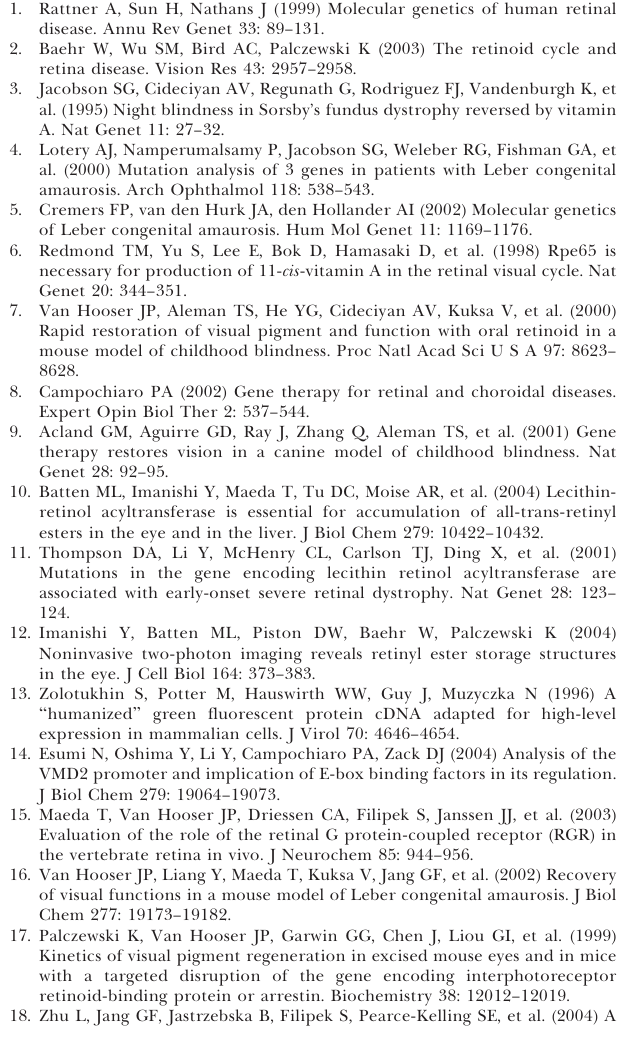
Figure S1. Chromatographic Separation of Retinoids Extracted from 16 Lrat (cid:2) / (cid:2) Mouse Eyes (A) Peak 1, syn-11- cis -RAL oxime; 2, undetermined compound with k max at 315 nm; 3, syn-all- trans -RAL oxime; 4, syn-9- cis -RAL oxime; 5,